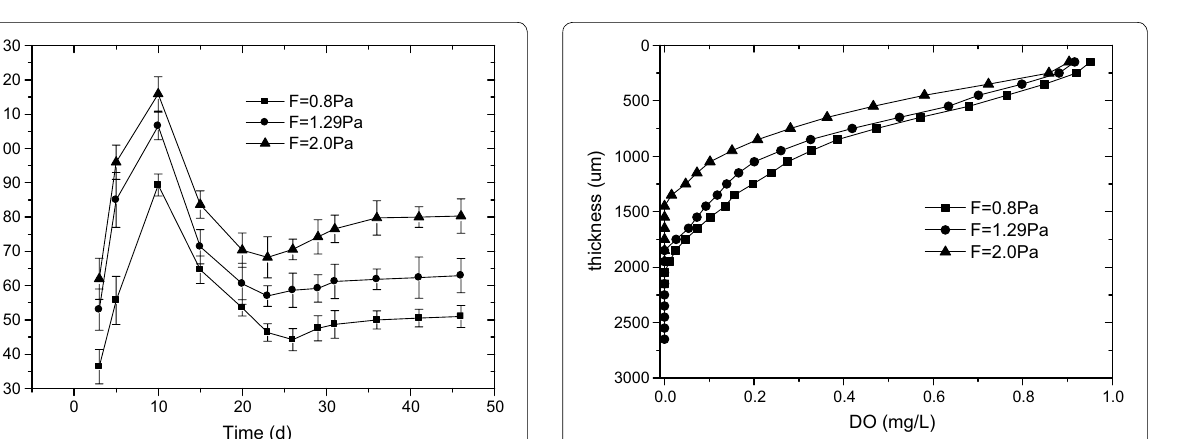
Fig. 4 Changes of dissolved oxygen in the biofilm with biofilm thick- ness, COD 400 mg/L. The changes of DO along the biofilm depth = under three wall-shear stresses were showed. Under three condi- tions, the DO fell along the biofilm depth and eventually decreased to zero. At the wall-shear stressed of 0.8, 1.29 and 2.0 Pa, the biofilm thicknesses where the dissolved oxygen reduced to zero were 2050, 1850 and 1450 μm, respectively. It revealed that the reduction rate of dissolved oxygen was positively correlated with the wall-shear